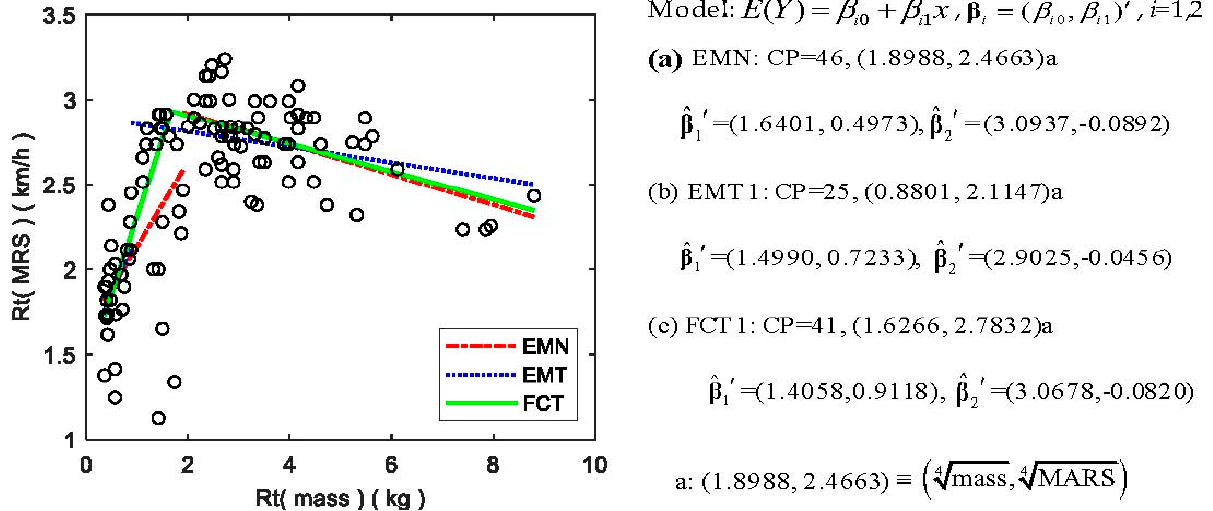
Figure 5. Fitting results of EMN, EMT and FCT to MARS data.